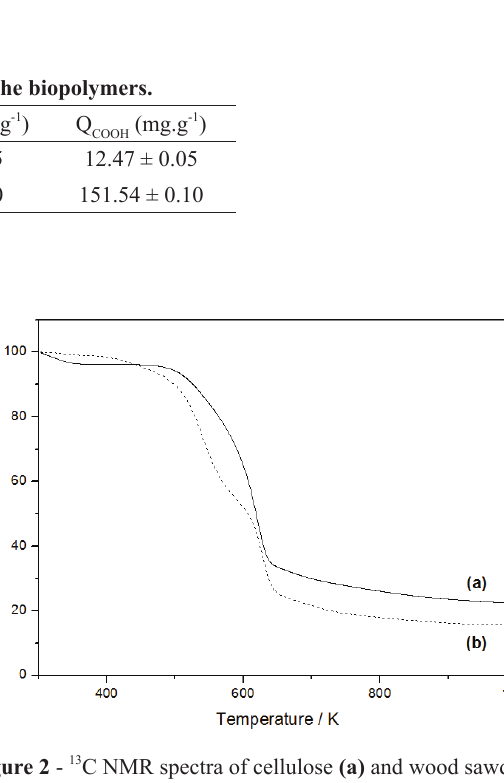
Figure 2 - 13 C NMR spectra of cellulose (a) and wood sawdust modified with succinic anhydride, SSA (b)